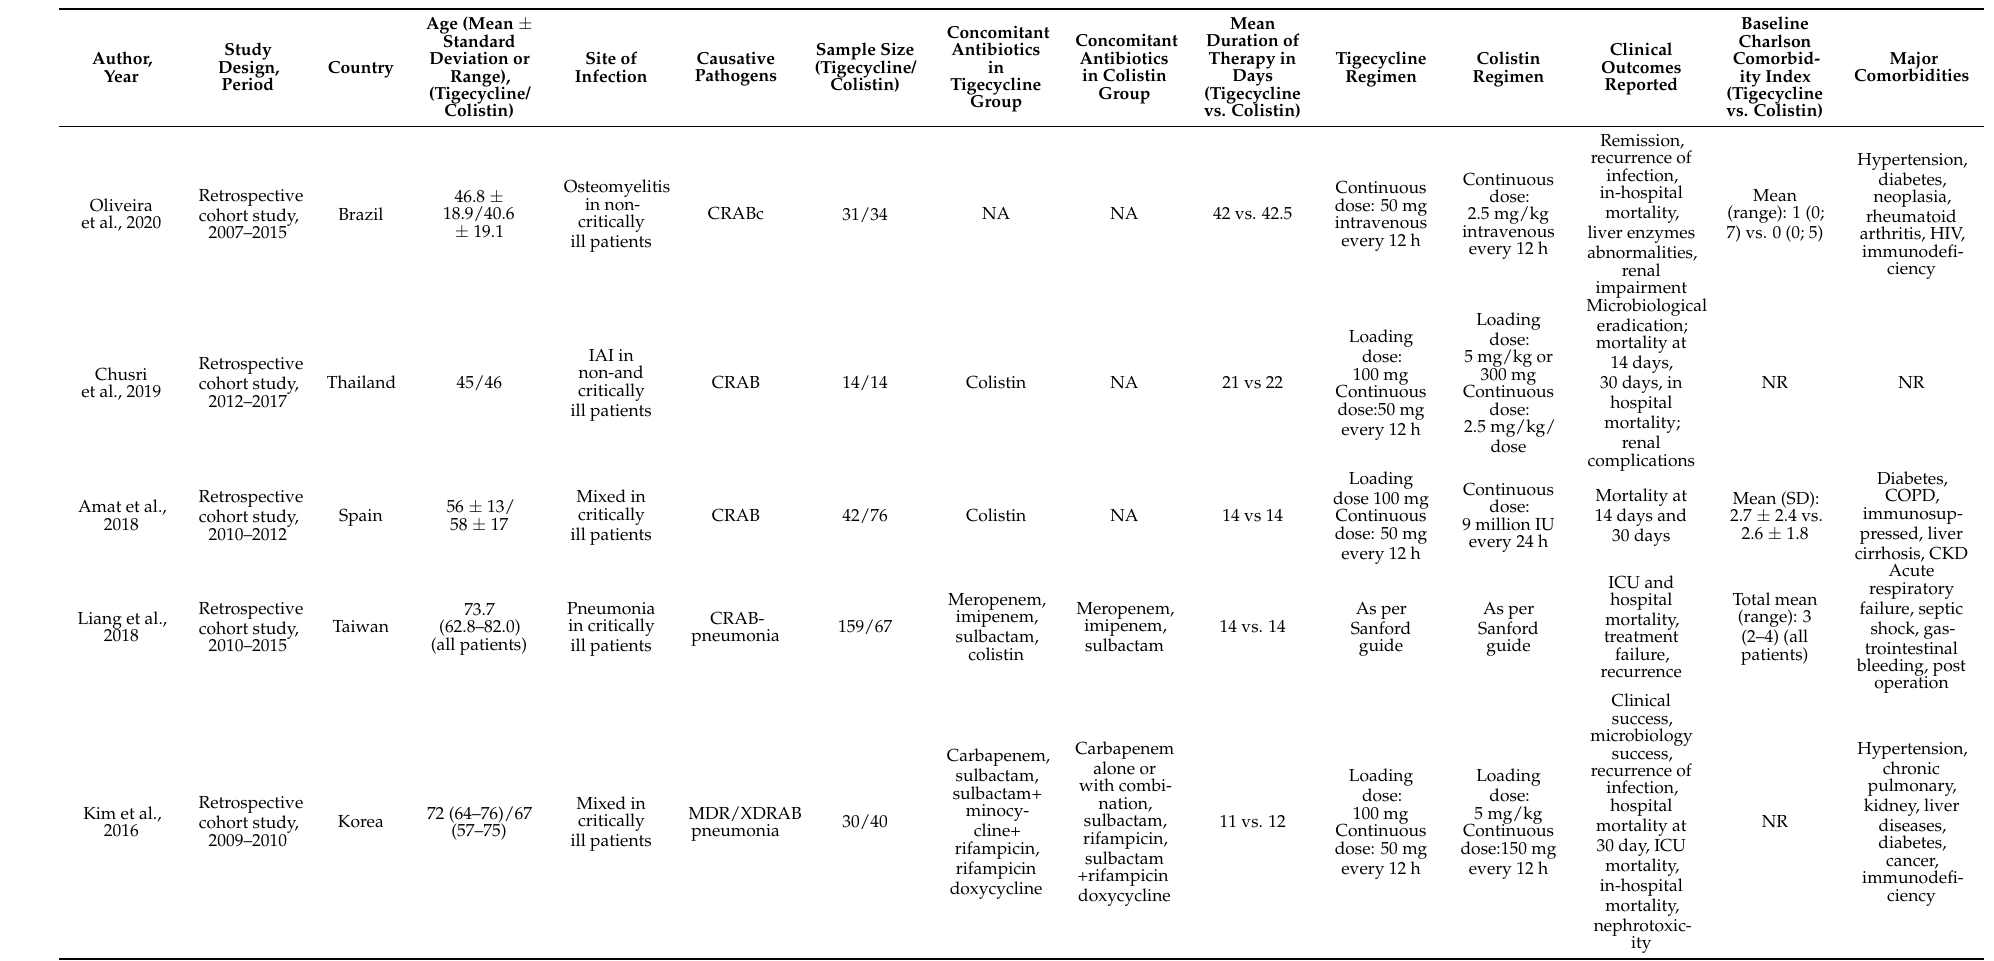
Table 1. Baseline characteristics and summary of included